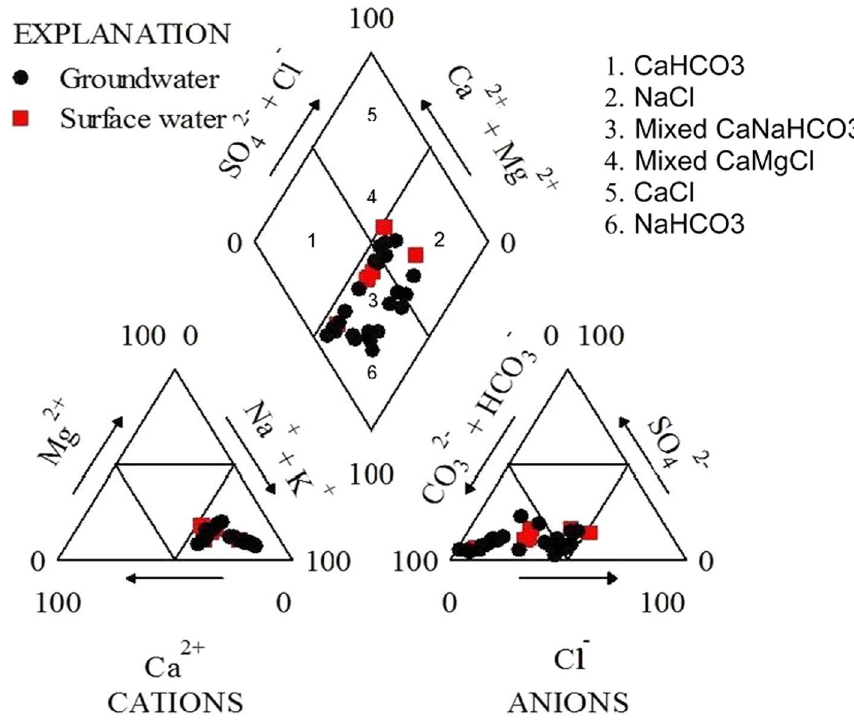
Fig. 16 The piper diagram, graphically displaying the 30 water samples from the Moth-